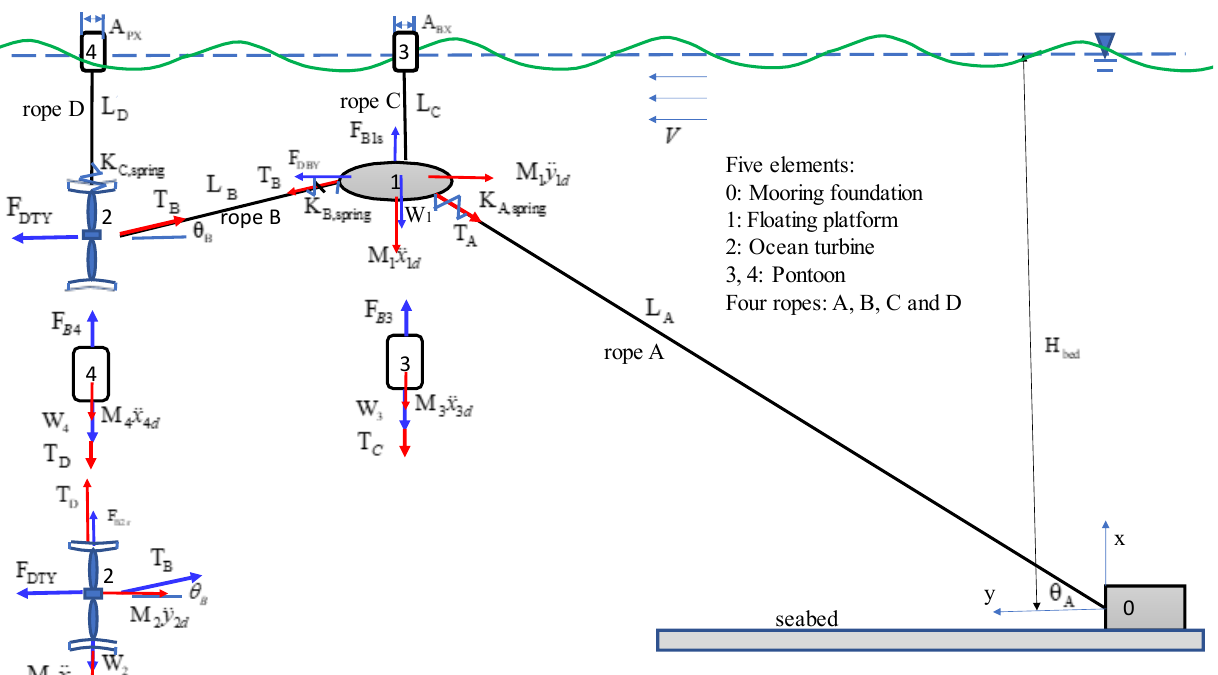
Figure 1. Coordinates of the current energy system composed of submarined ocean turbine, pontoons, floating platform, traction ropes and mooring foundation in the static state under steady ocean current.